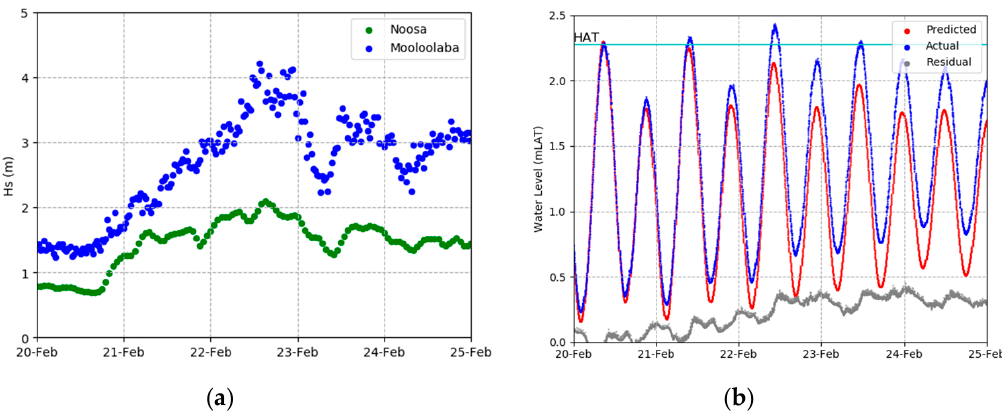
Figure 5. ( a ) Significant wave heights at Mooloolaba wave buoy (recorded) and Laguna Bay (Noosa) (modelled), and ( b ) predicted and recorded tidal levels for Noosa Main Beach, as projected from Maroochydore tide gauge.